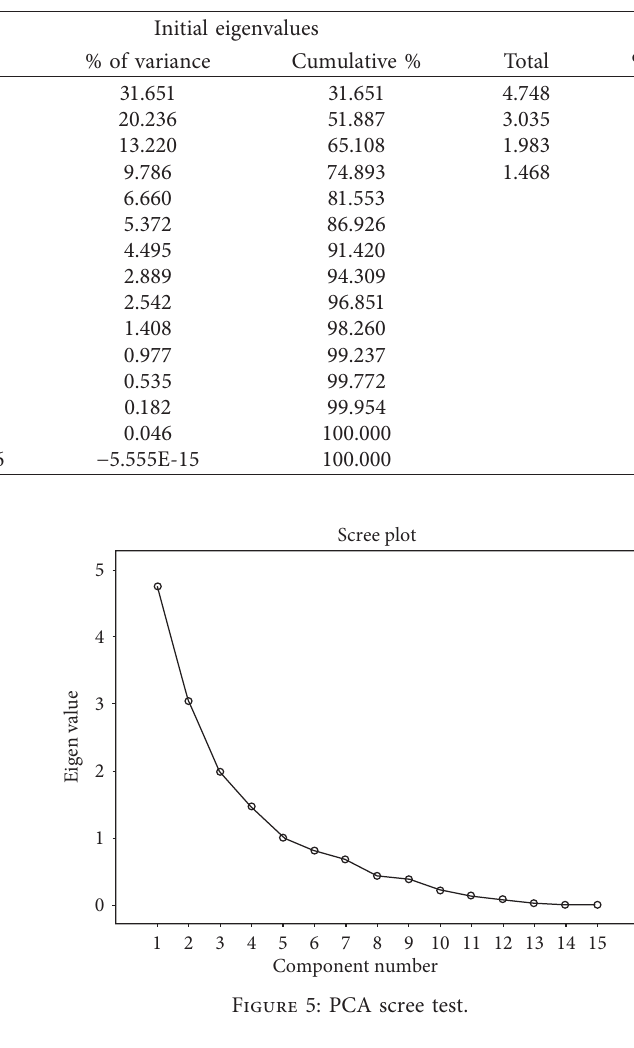
Table 5: Total variance explained.